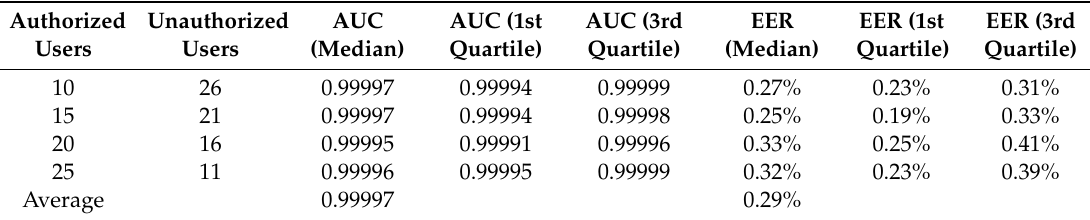
Table 3. Results of the verification experiments. The ability of the best CNN to di ff erentiate between authorized users and unauthorized users was evaluated in 4 × 25 trials. The 36 subjects were randomly assigned as authorized / unauthorized users for each trial, with four di ff erent